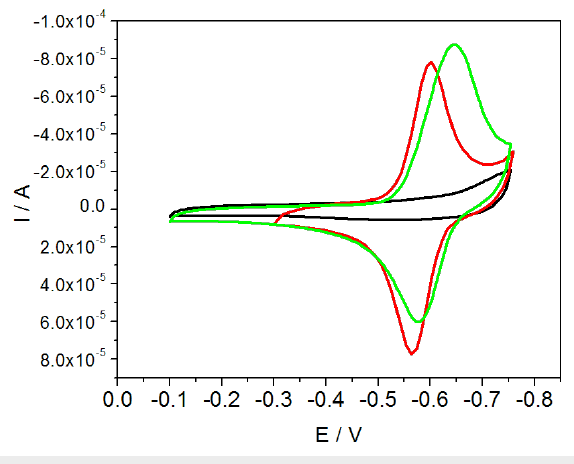
Figure 5: Cyclic voltammograms recorded for gold electrode modified with DPPTE monolayer (black), mixed DPPTE/SWCNTs-DNR (1:5 w/w) layer (red) and DPPTE monolayer exposed to 10 − 5 M DNR solu- tion for 600 s (green). Scan rate: 500